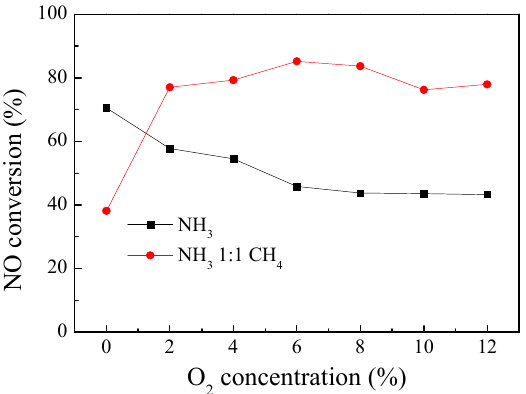
Figure 3. Effect of O 2 concentration on the NO conversion of the DBD–NH 3 –SCR and DBD–NH 3 –CH 4 –SCR process. The SIE of DBD was kept at 512 J/L, O 2 concentration ranged from 0% to 12% and other reaction conditions were the same as those in Figure 2.